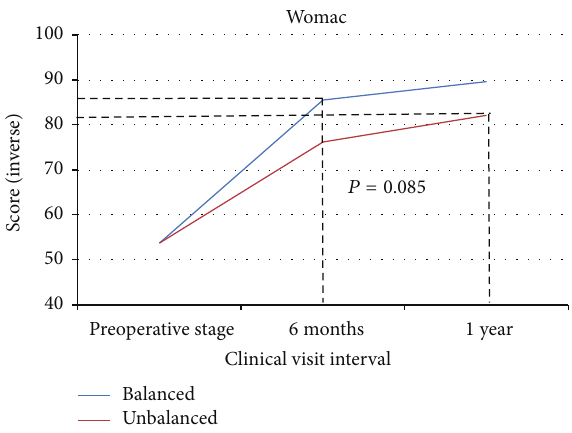
Figure 4: The lines represent the total WOMAC scores for the balanced and unbalanced patients from preoperative stage to 1 year. The dashed lines indicate the disparity between the balanced and unbalanced patients’ total WOMAC scores.